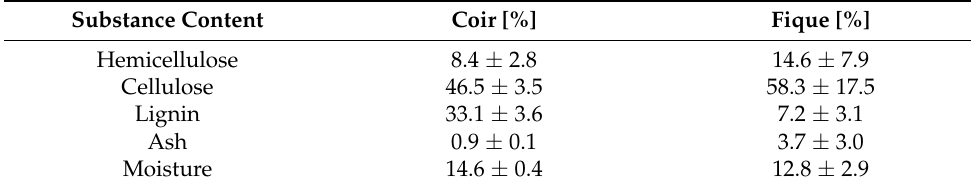
Table 1. Chemical composition of coir and fique fibers. Substance Content Coir